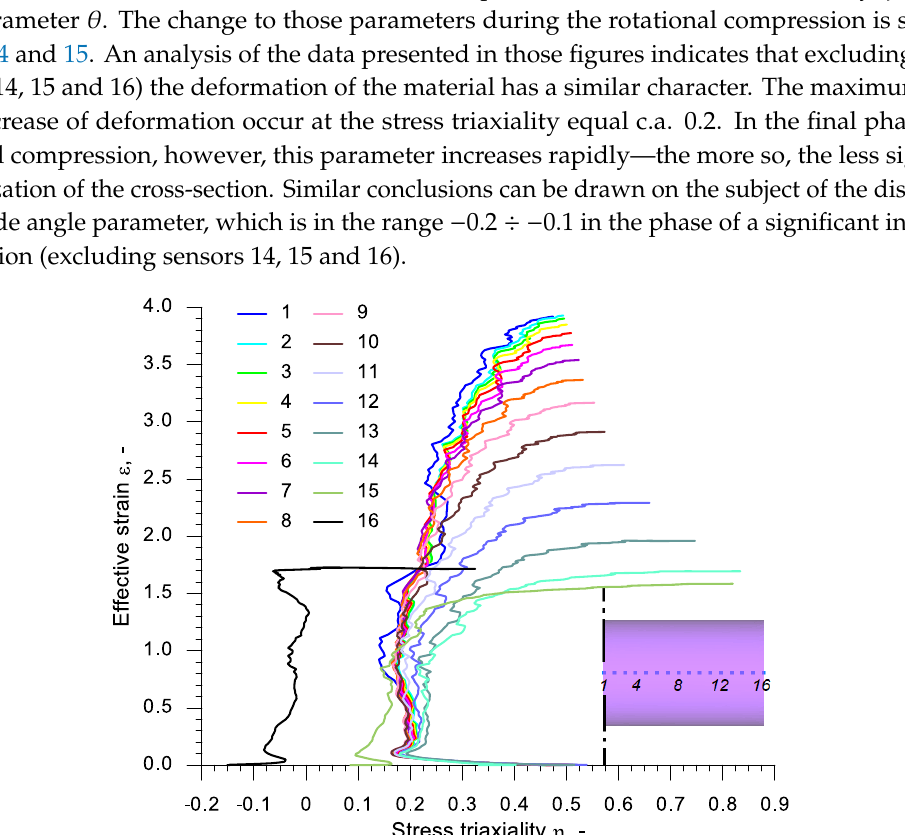
Figure 15. The dependency of effective strain on the Lode angle parameter in virtual sensors located in the axis of a sample with the length l 0 = 90 mm, subjected to rotational compression. The values determined for the 16 aforementioned virtual sensors were used to obtain the points on the plane of stress state that represents the state of stress in the new rotational compression test (Figure 16). Moreover, on this plane, the calibration tests proposed by Wierzbicki et al., presented in Table 2, were marked. An analysis of the data from this chart indicates that that the stress state in the test differs from the ones from the tests performed thus far. The points representing the state of stress in the middle of the rotational compressed sample are located in area defined by the ordinates η (0.2; 0.3) and θ (−0.2; −0.1). This location differed significantly from the points representing the state of stress at the end of the sample.